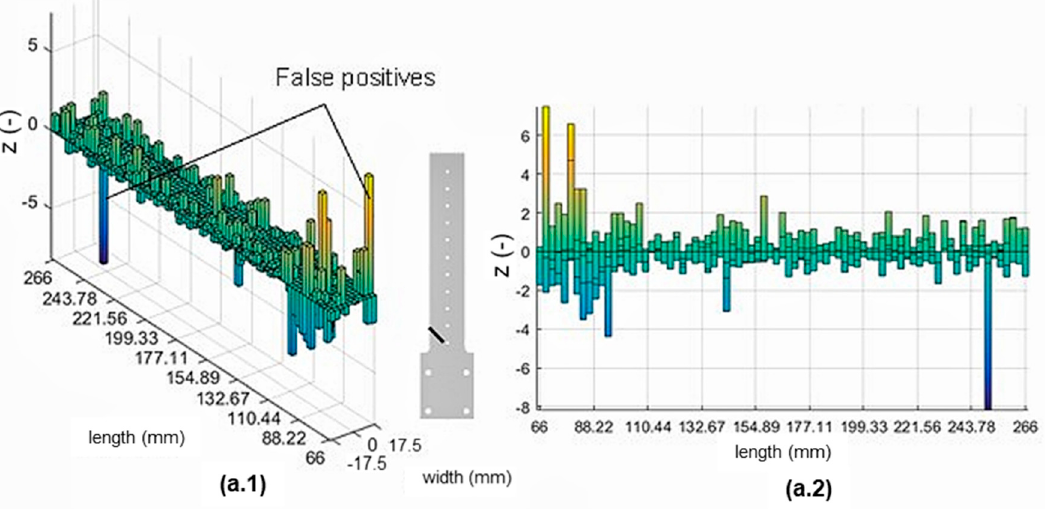
Figure 8. MSE-DI implementation to simplified ABS sample (skin only): ( a.1 , a.2 ) 45 ◦ cracked sample. Based on these plots, it could be inferred that peaks appeared at particular locations with a significantly higher normalised damage index than the rest. Several false positives or peaks appearing at locations with no defects could also be Table 3. The fi rst mode natural frequency of MSE-DI simpli fi ed ABS skin models. Sample ID